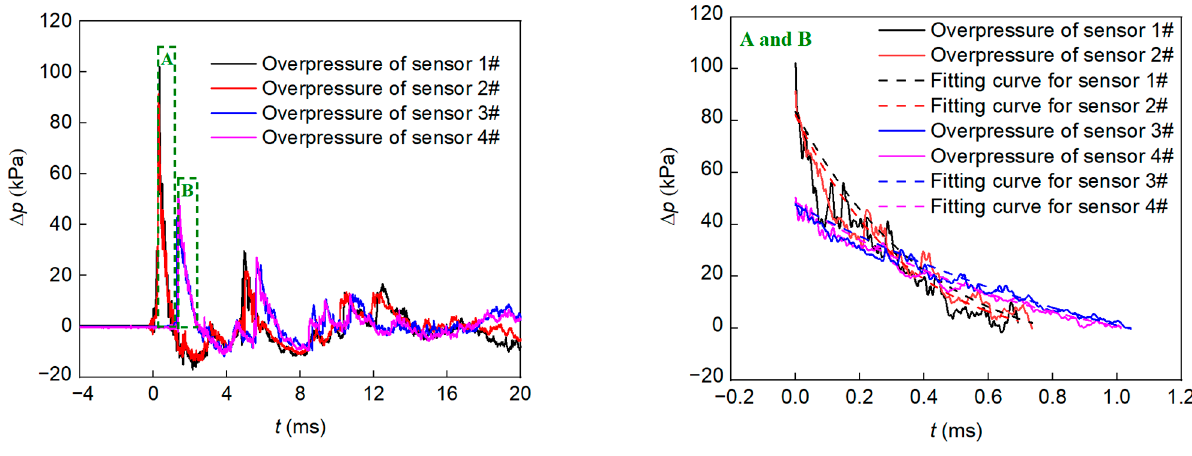
Figure 7. Details of the test site layout.